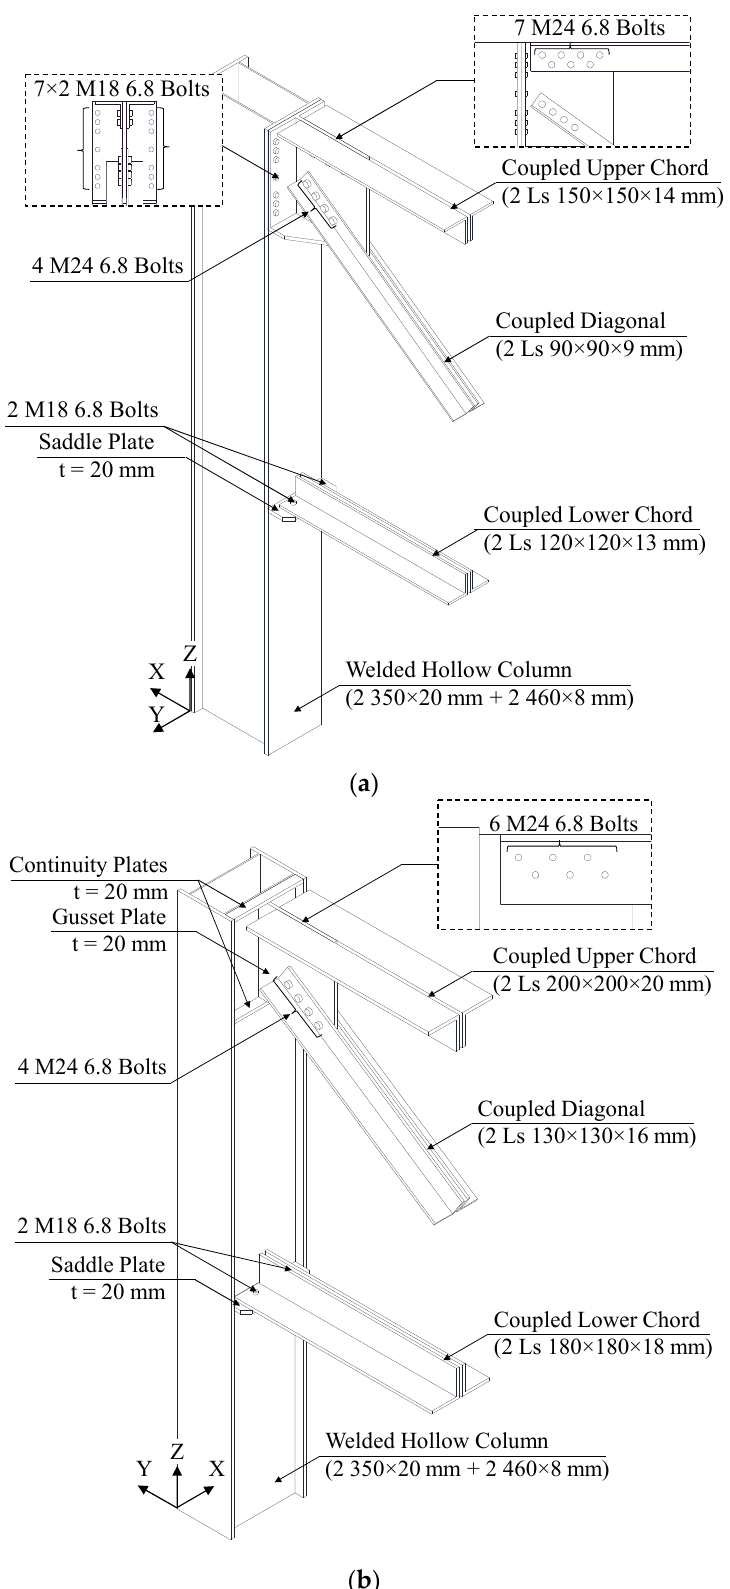
Figure 3. Details of truss-to-column connections adopted for MRFs: ( a ) X-direction and ( b ) Y-direction.